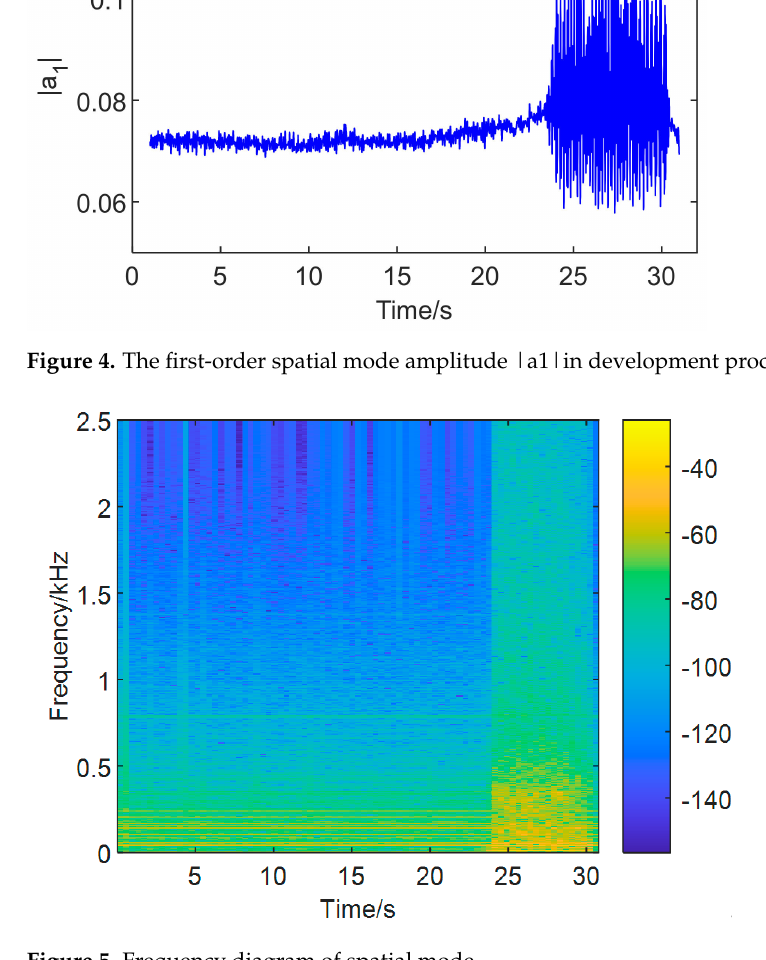
Figure 5. Frequency diagram of spatial mode.